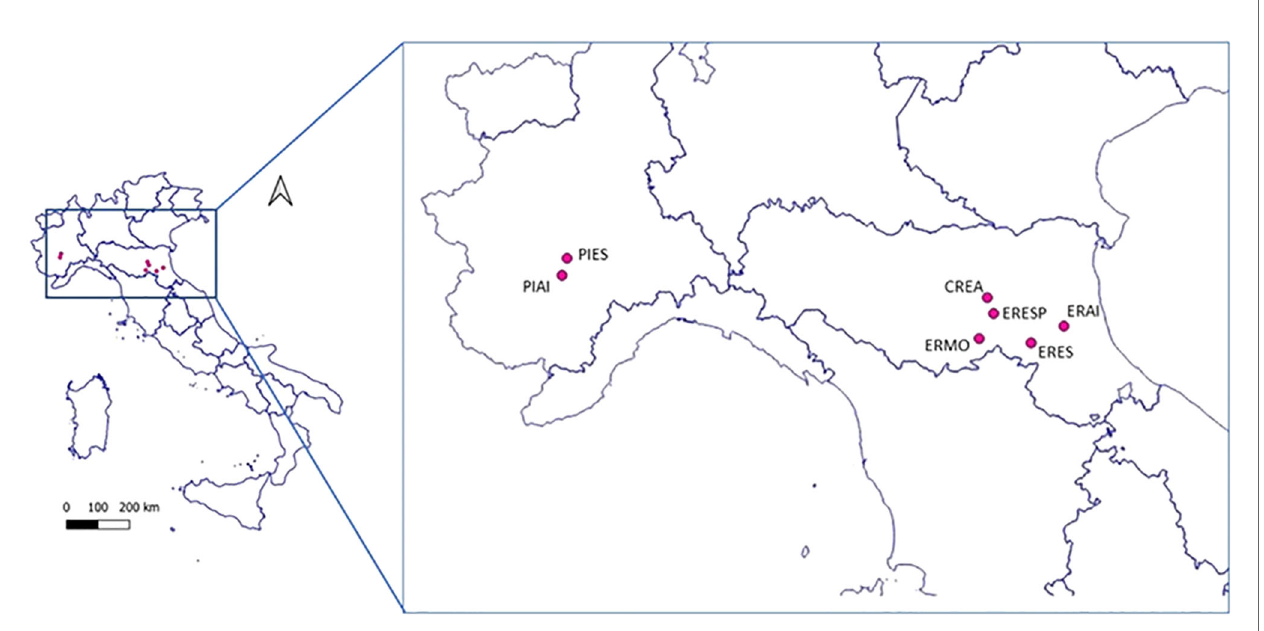
FIGURE 1 | Geographical localisation of the investigated sampling